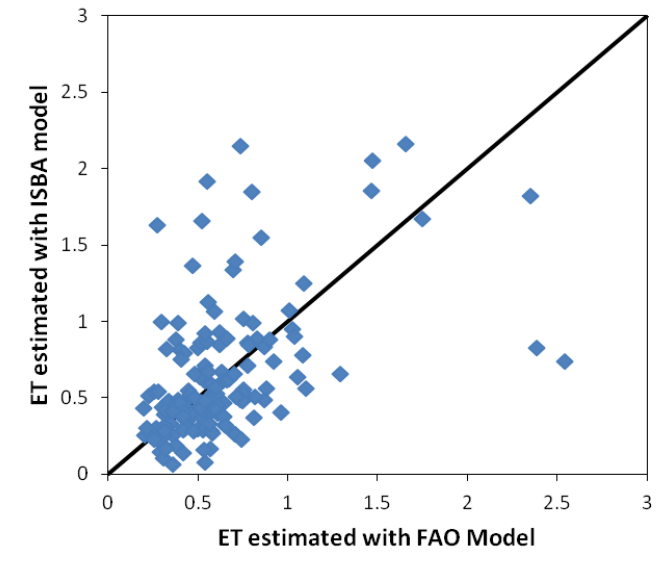
Figure 4. Evapotranspiration (ET) simulated by the ISBA-A-gs model as a function of the ET levels simulated by the FAO-56 model over a single ISBA pixel, during the period from 1991–2007, and on dates when remotely sensed ERS/WSC observations were